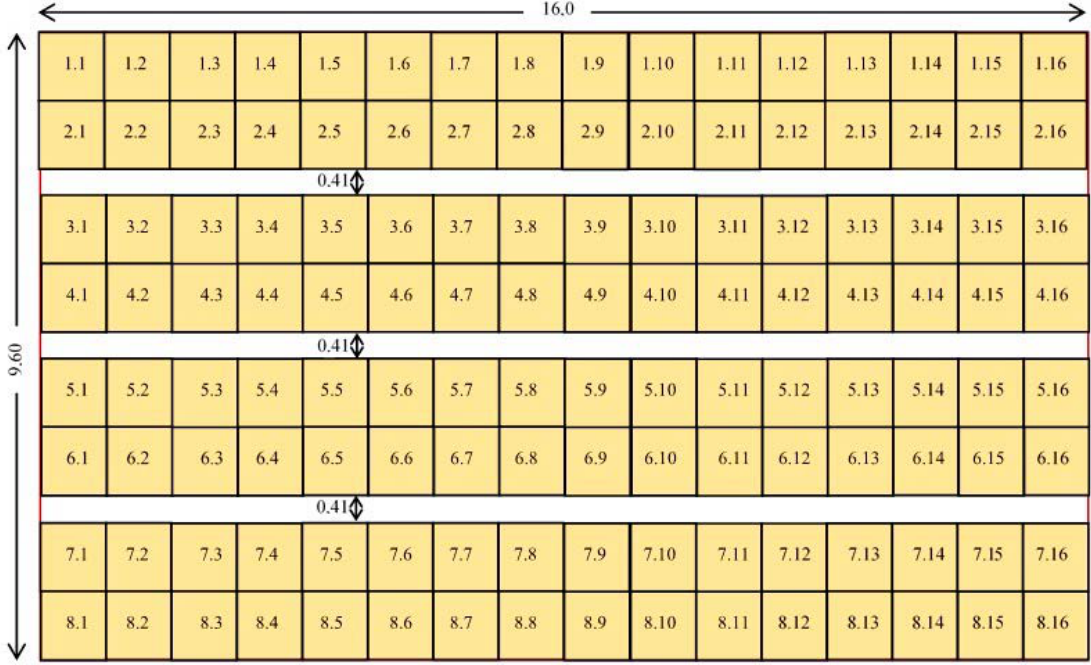
Figure 8. Roof expansion and positioning of 128 PVs type Sxp154Q by Solbian, 16 PVs in the East–West axis and 8 PVs in the North–South axis with 3 corridors with a width of 41 cm and nominal power 19,712 W.